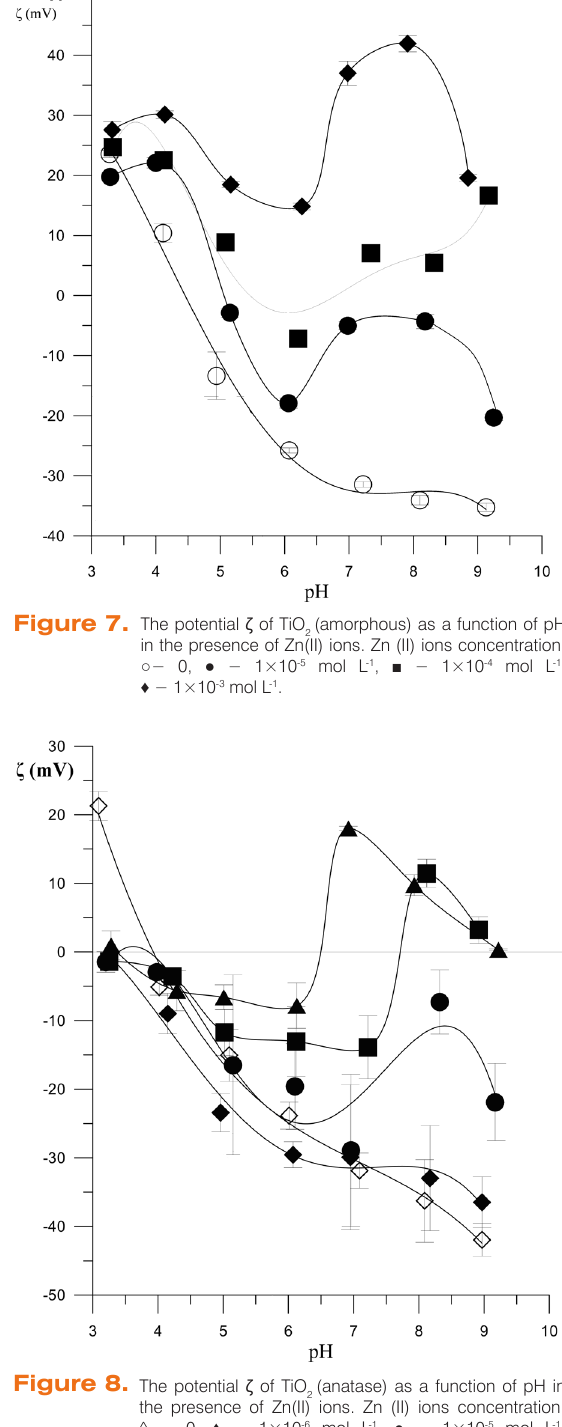
Figure 8. The potential ζ of TiO (anatase) as a function of pH in 2 the presence of Zn(II) ions. Zn (II) ions concentration: